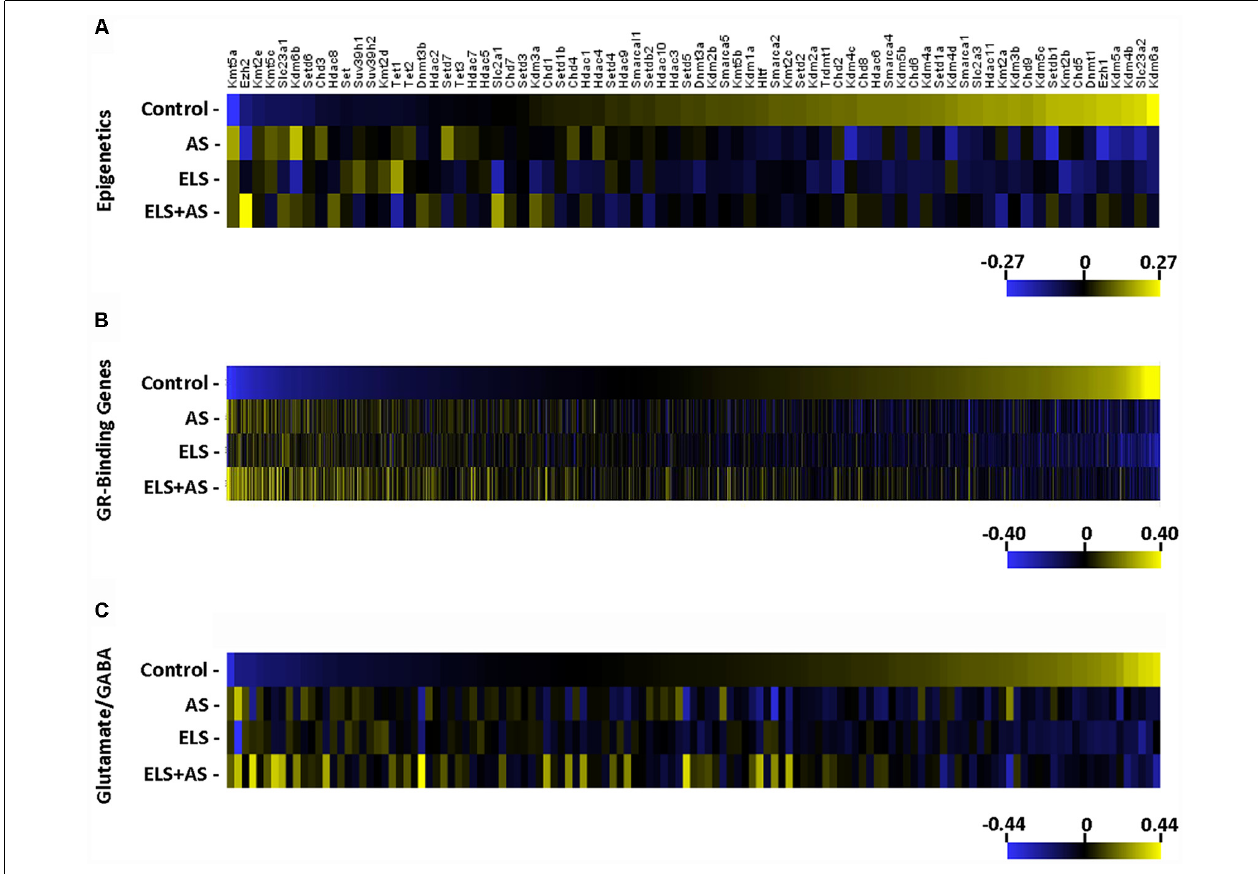
FIGURE 3 | Regulation of gene expression induced by AS and ELS. (A–C) Heatmaps represent the log2 transformation of counts from 74 epigenetic genes, 1,506 GR-binding genes, and 127 glutamate/GABA genes. Genes are organized by lowest to highest expression in the unstressed control group. The majority of genes in each heatmap is downregulated in stressed controls and unstressed ELS mice, but unchanged in stressed ELS mice. ELS, early life stress; AS, acute